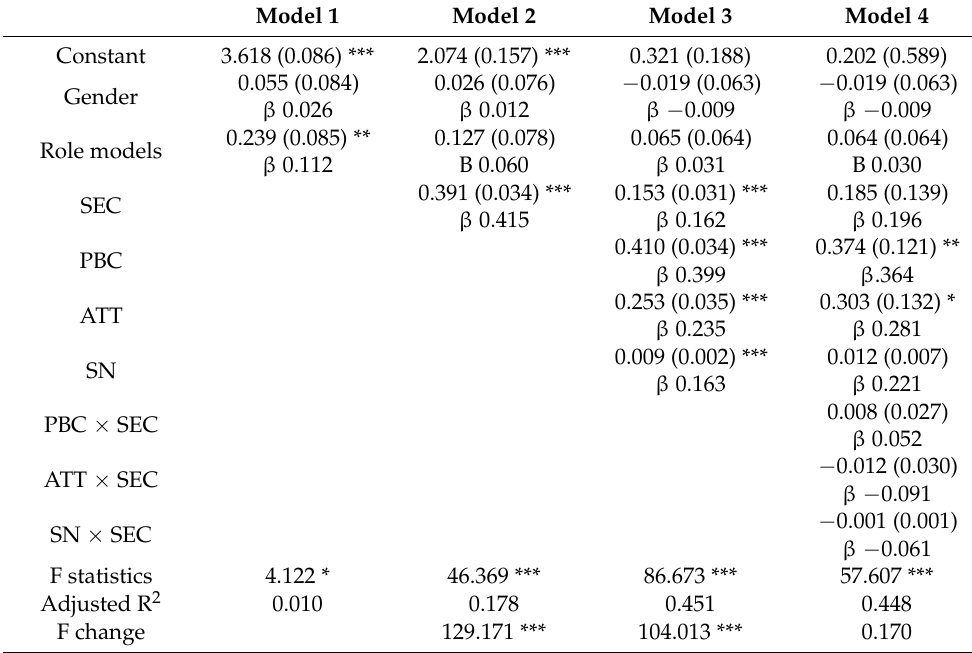
Table 4. Results for secondary-level